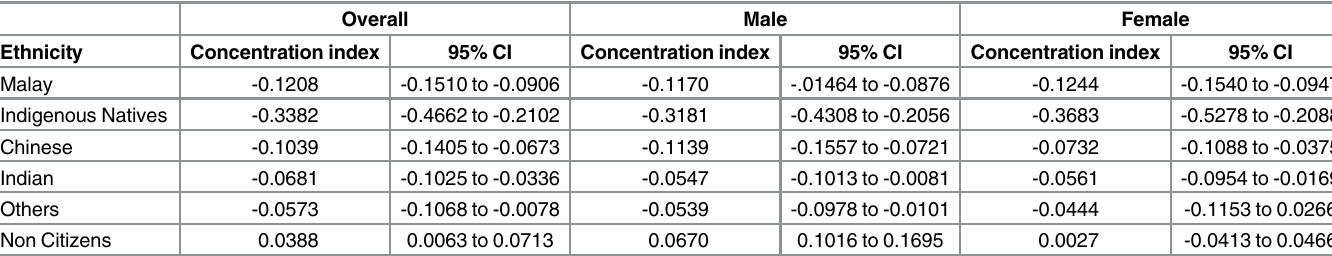
Table 4. Concentration Indices and 95% Confidence Intervals for PYLL by Ethnicity for All-Cause Mortality. Overall Male Female Ethnicity Concentration index 95%